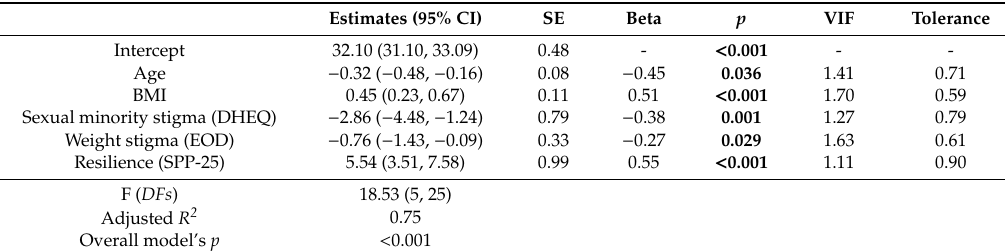
Table 2. The predictors of self-esteem in the group of Bear-identified men (N = 31) tested by linear regression model.